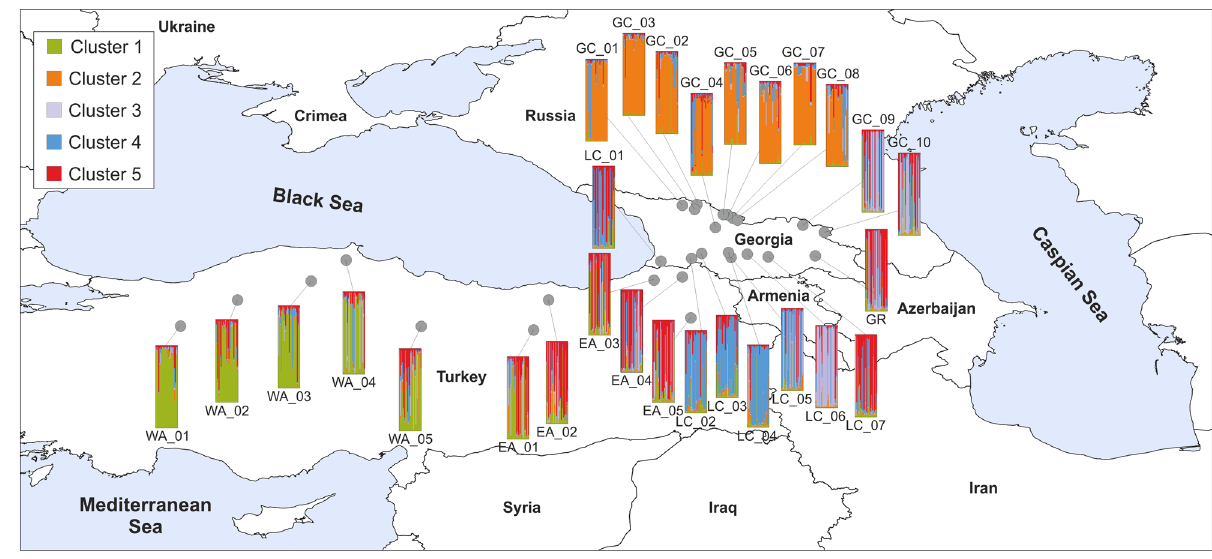
Figure 2. Location of the studied populations of Scots pine in the South Caucasus and Anatolia and the results of the STRU CTU RE analysis conducted using nuclear microsatellites. Bar plots present the proportion of membership of each individual in the five clusters indicated (K = 5). Map generated with QGIS 3.16 (https:// qgis. org/ en/